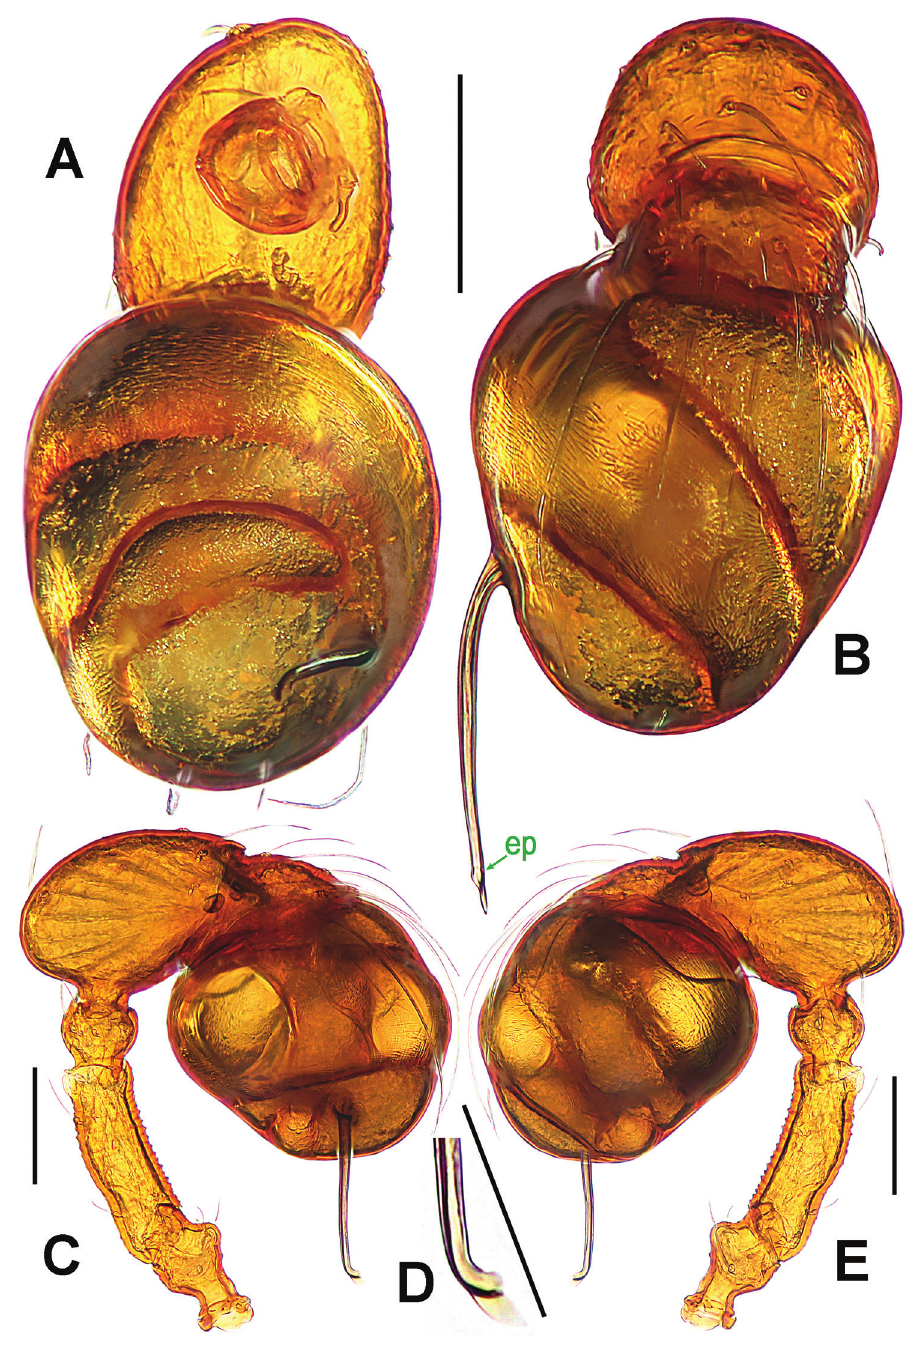
Figure 17. Singaporemma lenachanae sp. n., male holotype. A palpal bulb, ventral B left palp, anterior C ditto , prolateral D embolic end, prolateral E left palp, retrolateral. Abbreviation: ep = embolic part of apes of palpal organ. Scale bars: 0.10